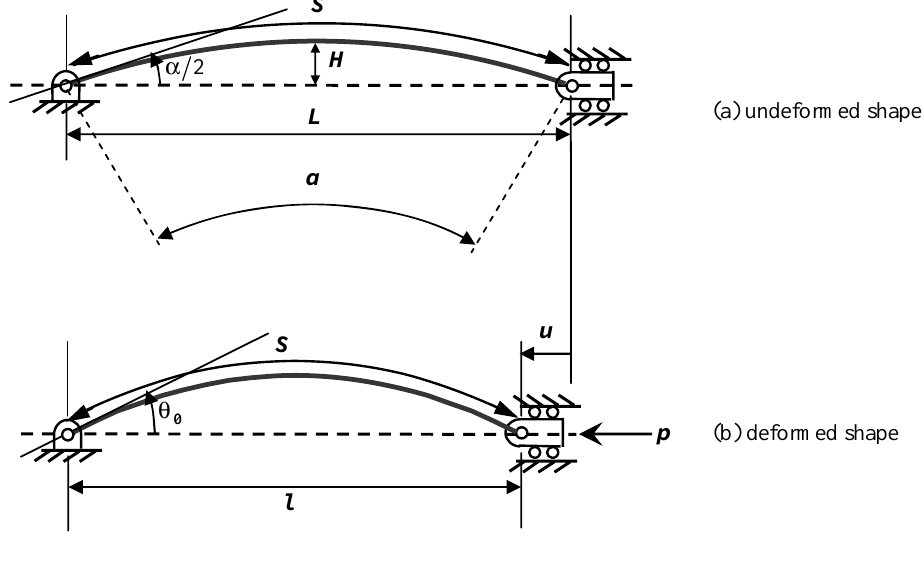
Fig. 4. Curved beam loaded along its